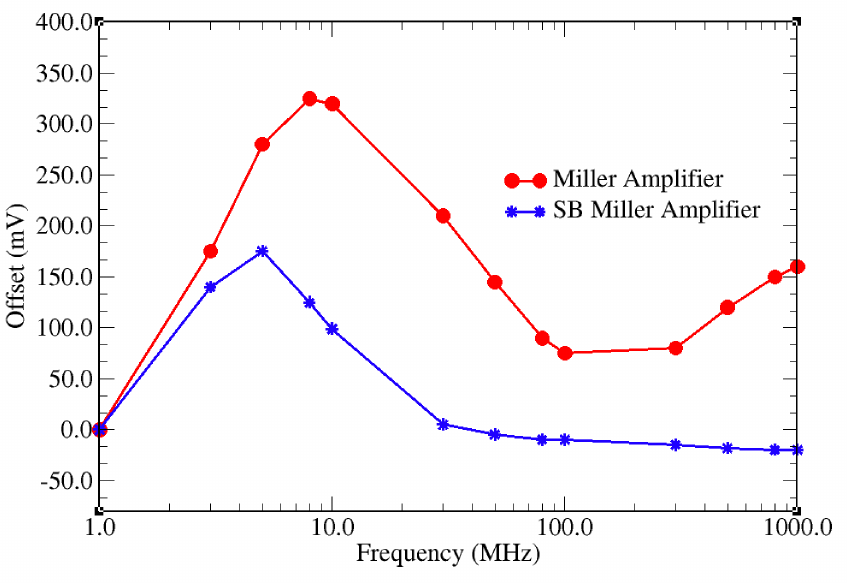
Figure 3. Offset induced by 900 mVpp electromagnetic interference (EMI) in classic and SB Miller